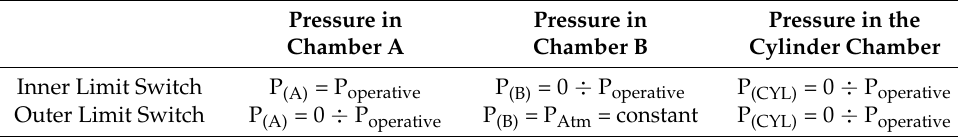
Table 1. Pressure values in the chambers of the limit switch systems.